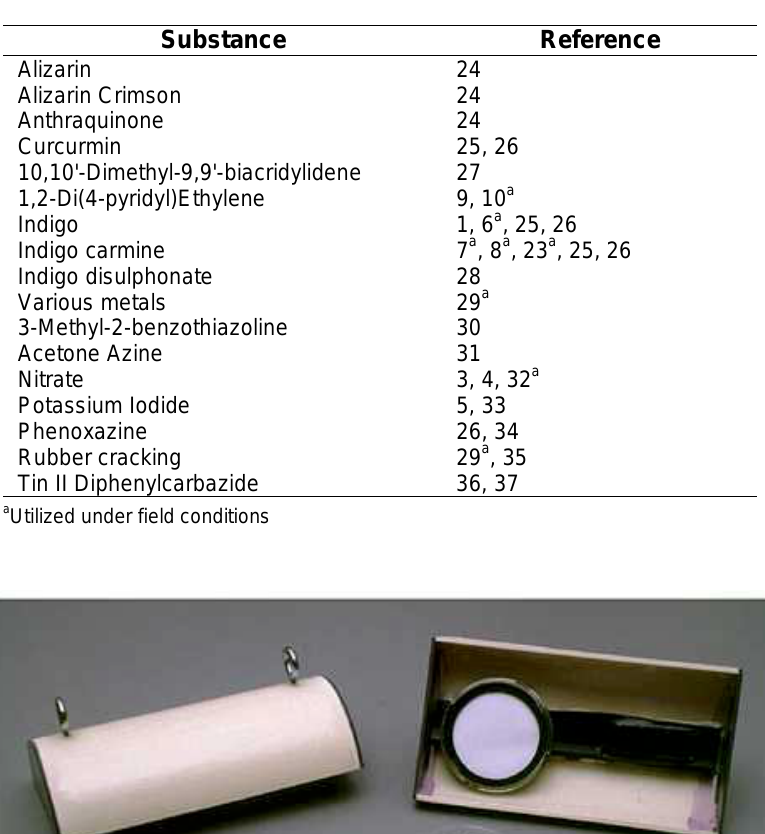
Examples of Substances Evaluated for their Potential Use as